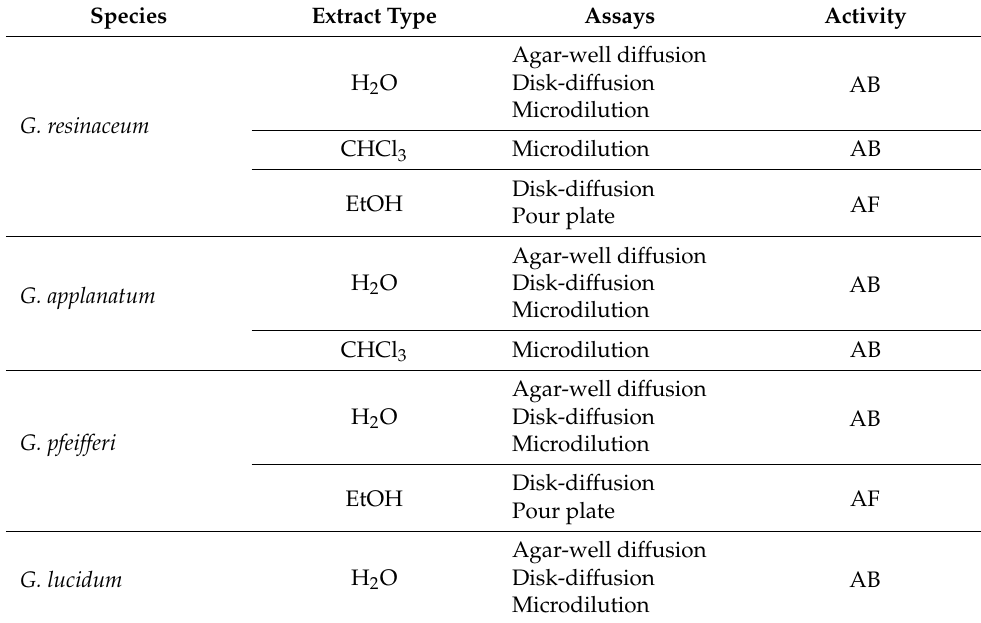
Table 5. Used assays and antimicrobial activity of different Ganoderma species